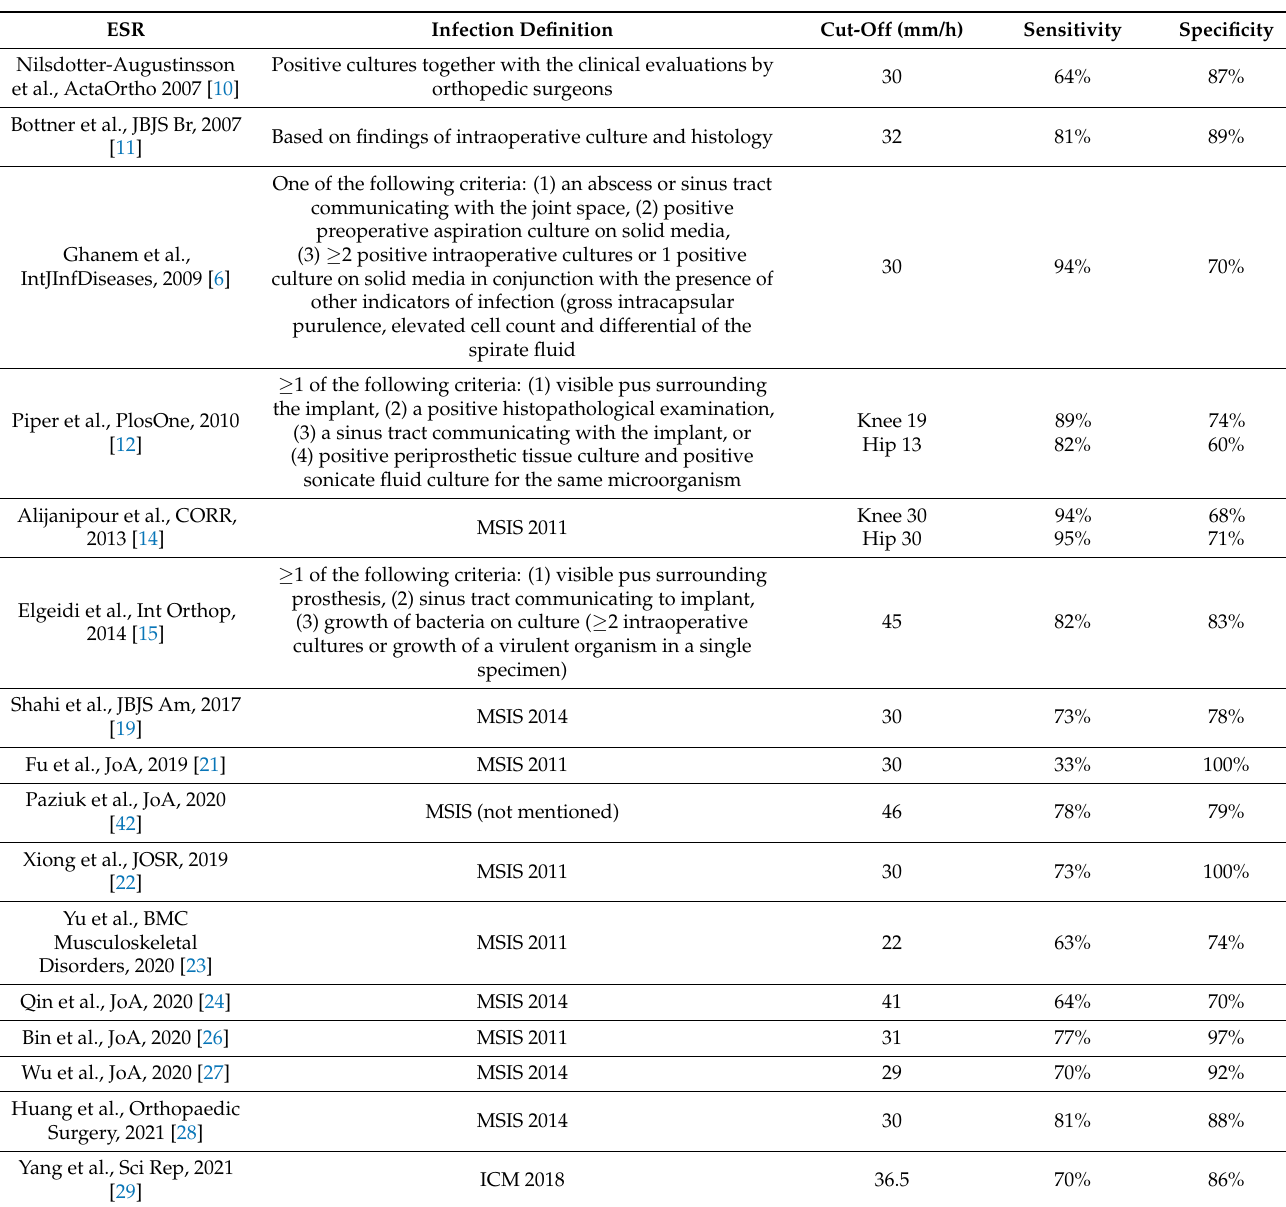
Table 2. Comparison of the literature regarding the erythrocyte sedimentation rate (ESR) in the diagnosis of periprosthetic joint